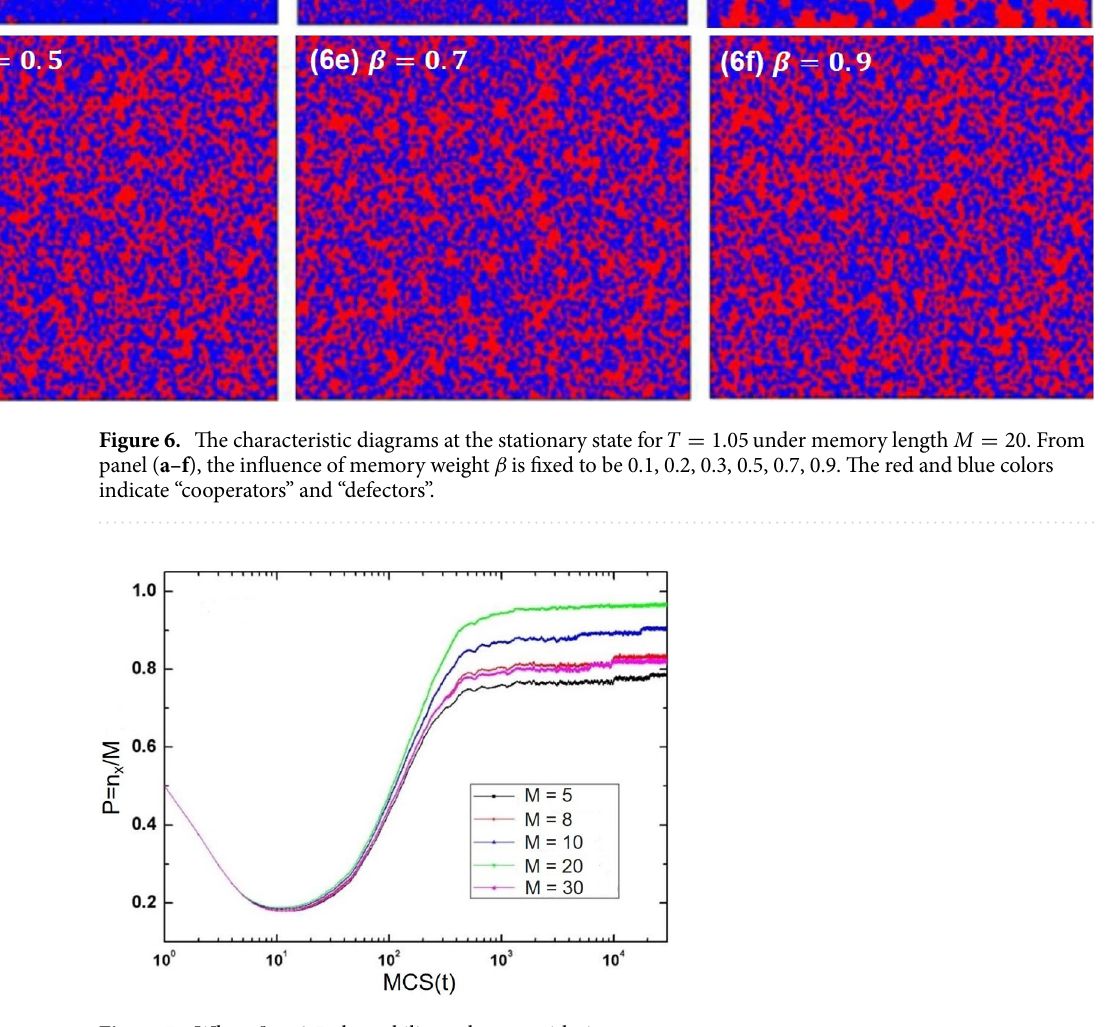
Figure 7. When β = 0.5 , the stability ρ changes with